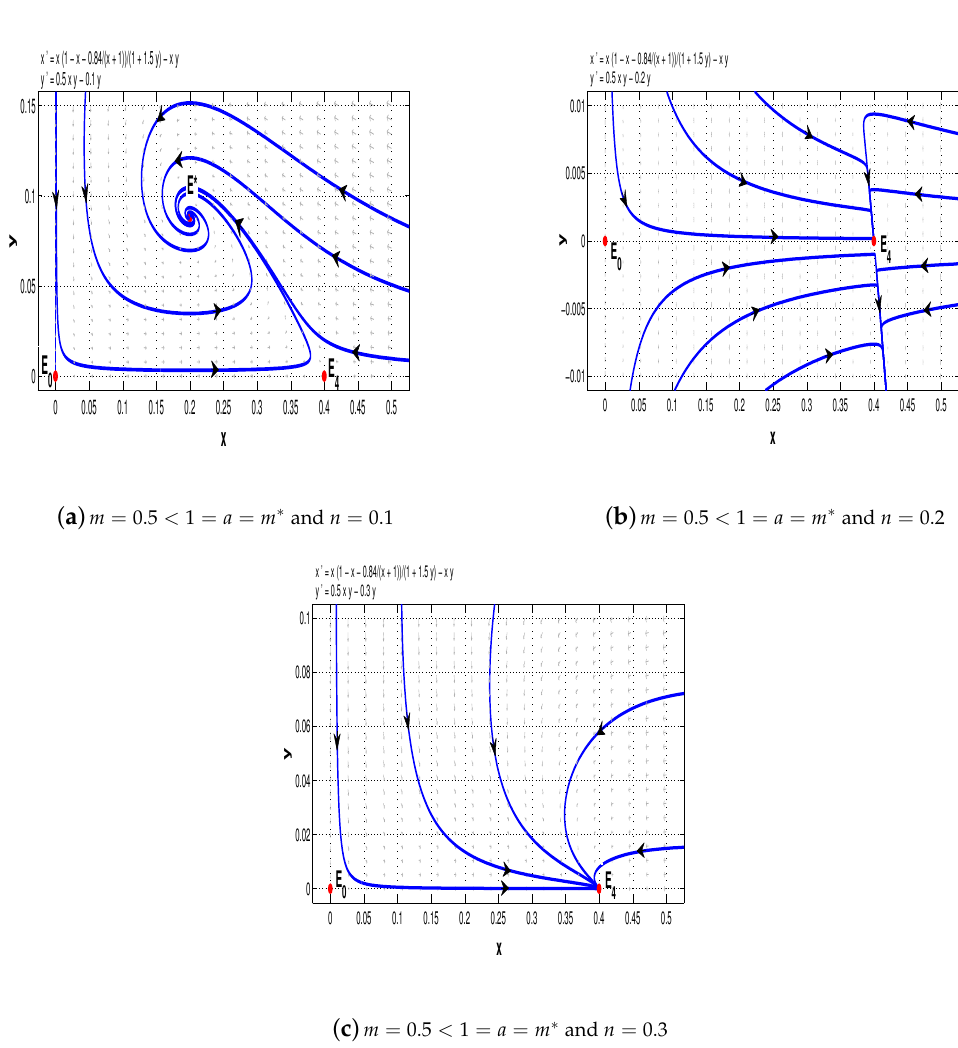
Figure 9. ( a ) When m = 0.5 < 1 = a = m ∗ and n = 0.1, there are two saddle points E 0 and E 4 , and a stable node E ∗ . ( b ) When m = 0.5 < 1 = a = m ∗ and n = 0.2, E 0 is a saddle and E 4 is a saddle-node. ( c ) When m = 0.5 < 1 = a = m ∗ and n = 0.3, E 0 is a saddle and E 4 is a stable